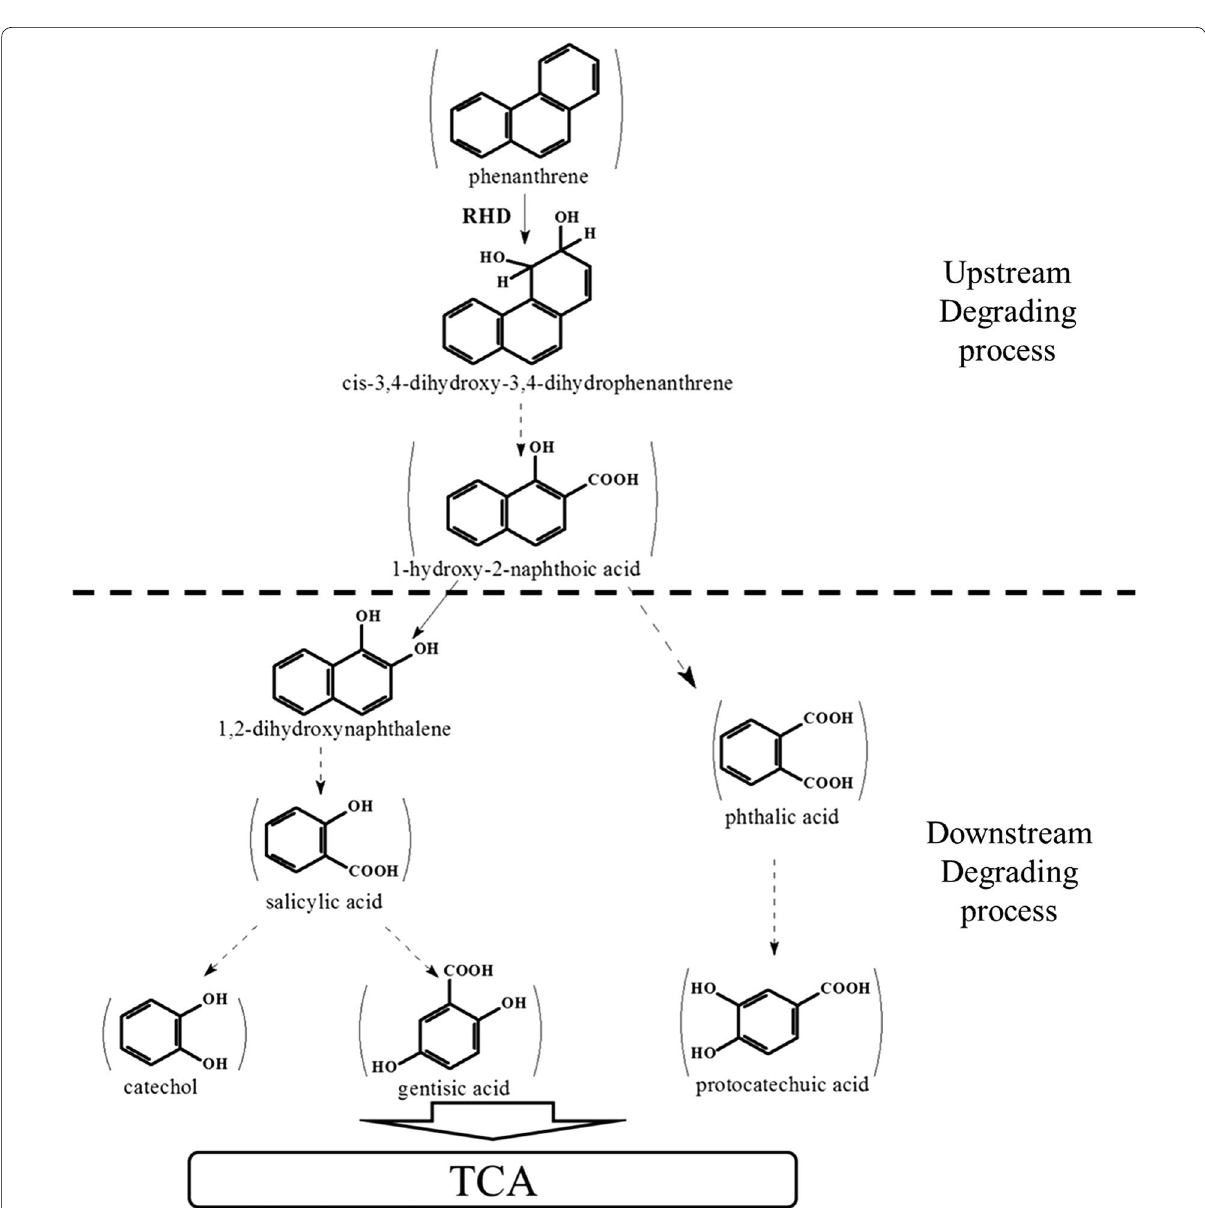
Fig. 3 Proposed phenanthrene degradation pathway in the halophilic consortium CY-1. Compounds detected were shown in bound. Solid arrows indicate a single reaction while broken arrows represent two or more transformation